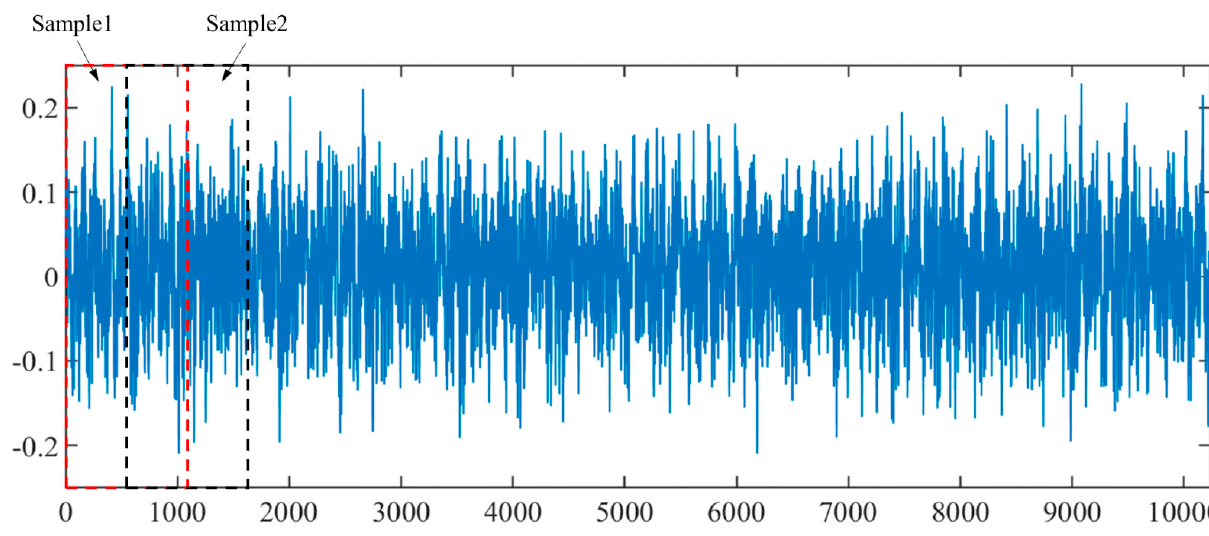
Figure 3. Vibration signal expansion mode. Table 1. Composition of experimental samples.